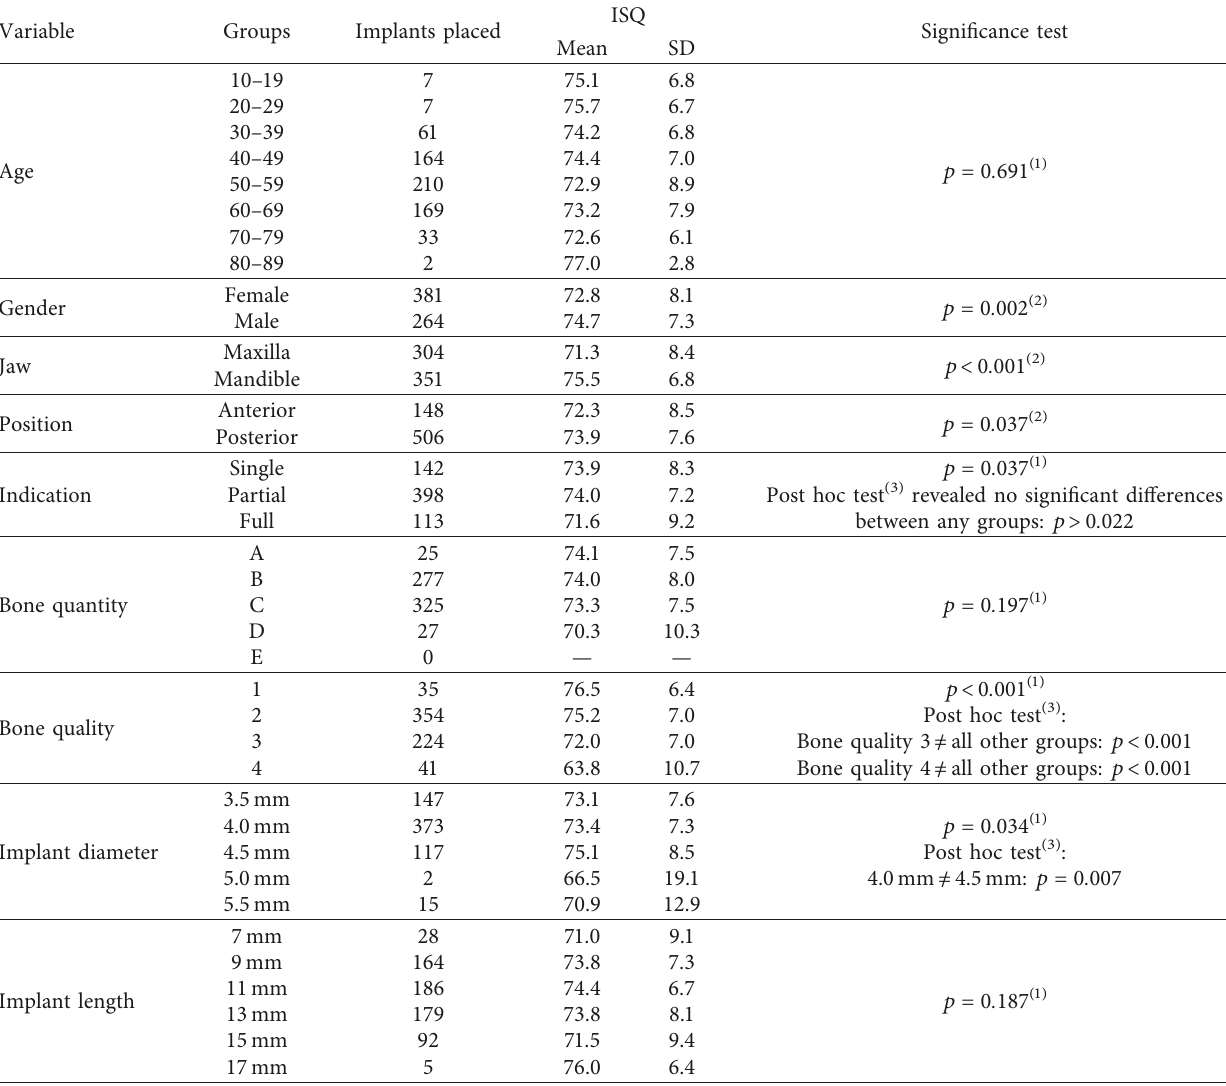
Table 7: Analyses of implant stability at implant